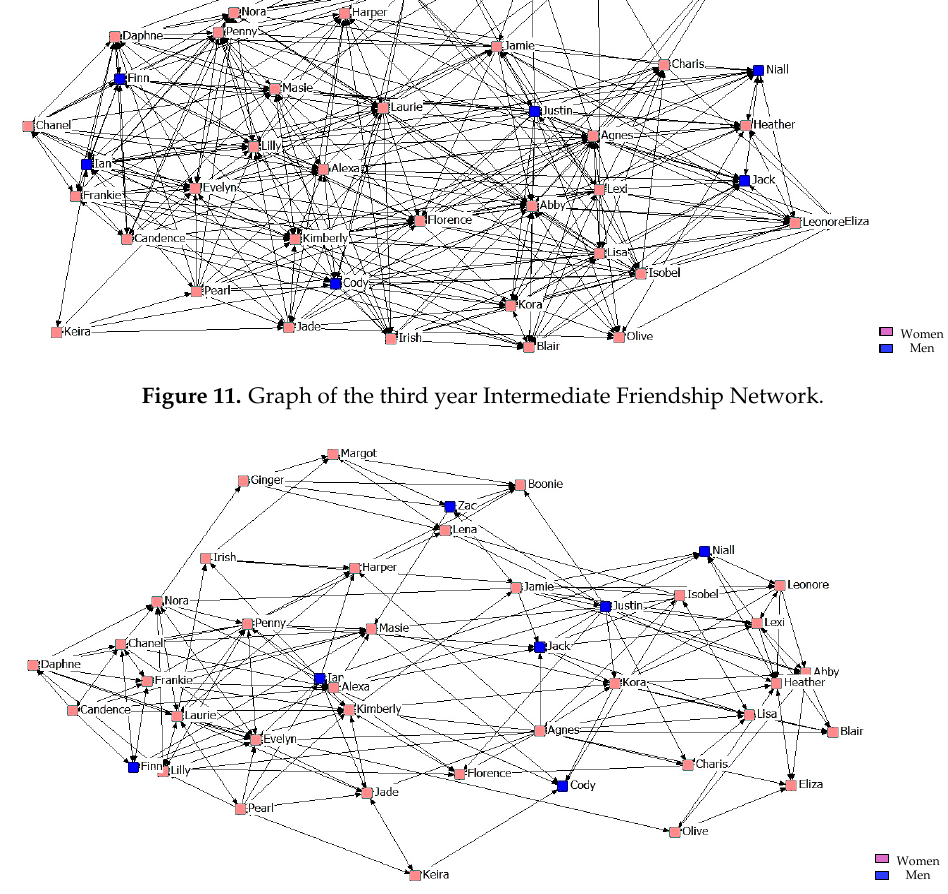
Figure 12. Graph of the third year Maximum Friendship Network.